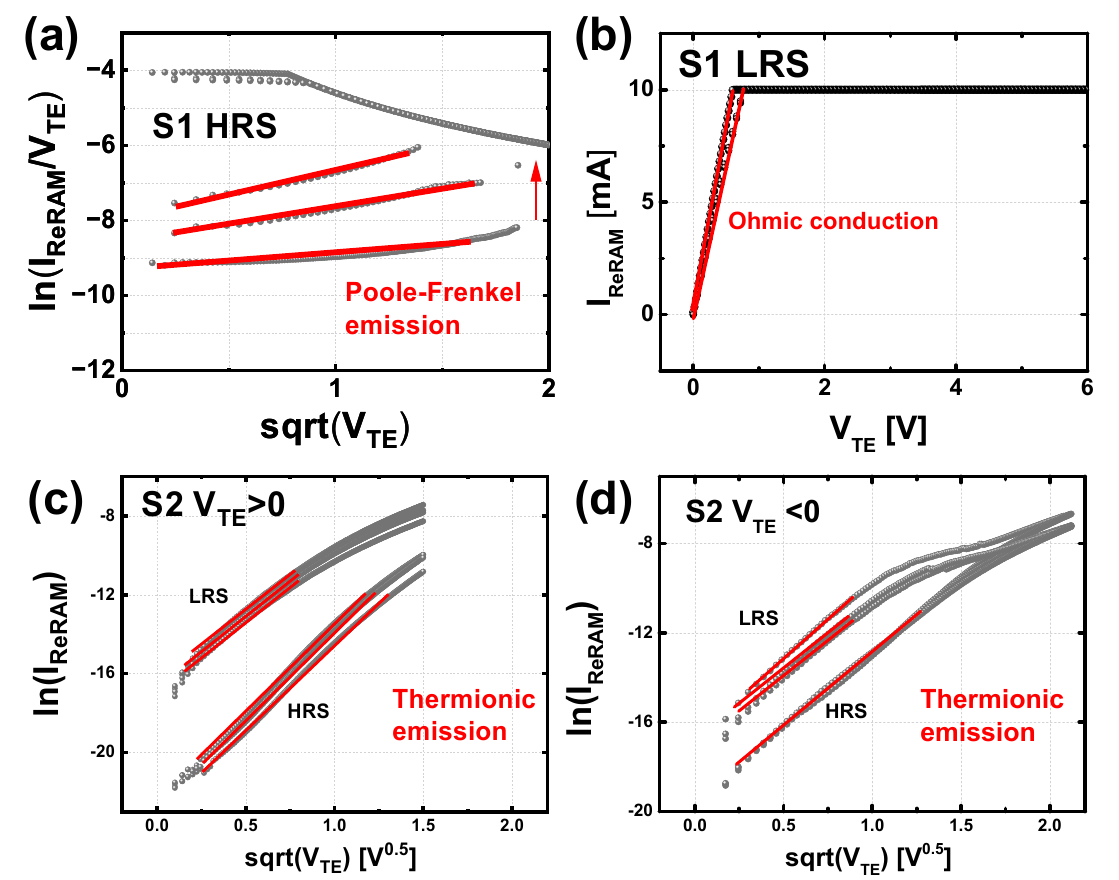
Figure 3. Replotted I – V switching characteristics of a total of 3 devices. ( a , b ) log( I / V )–sqrt( V ) plots of S1 and ( c , d ) log( I )–sqrt( V ) plots of S2 under positive and negative bias conditions. To analyze the switching mechanisms of both samples more thoroughly, the flat band diagram and energy band diagram at equilibrium, including work function, electron af- finity, and bandgap of the S1 and S2, are illustrated in Figure 4a,b, respectively [47,48]. It is expected that the Schottky barrier near the BE of the S1 is 0.8 eV and can become small similar to the ohmic junction, after the forming process. On the other hand, the SiO 2 layer inherently formed during the deposition step is placed between the IGZO and BE layers and forms a higher SB than the S1, resulting in a lower-level operation current. It is ex- pected that the device state of the S2 can be controlled by the electron trapping at the interface states between the IGZO and SiO 2 layers, leading to the gradual switching char- acteristics.